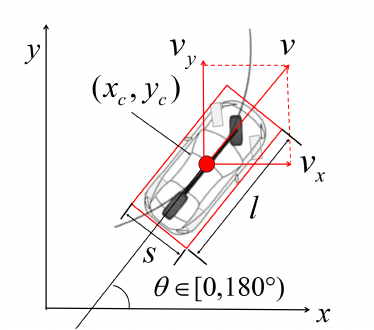
Figure 8. Vehicle steering model and